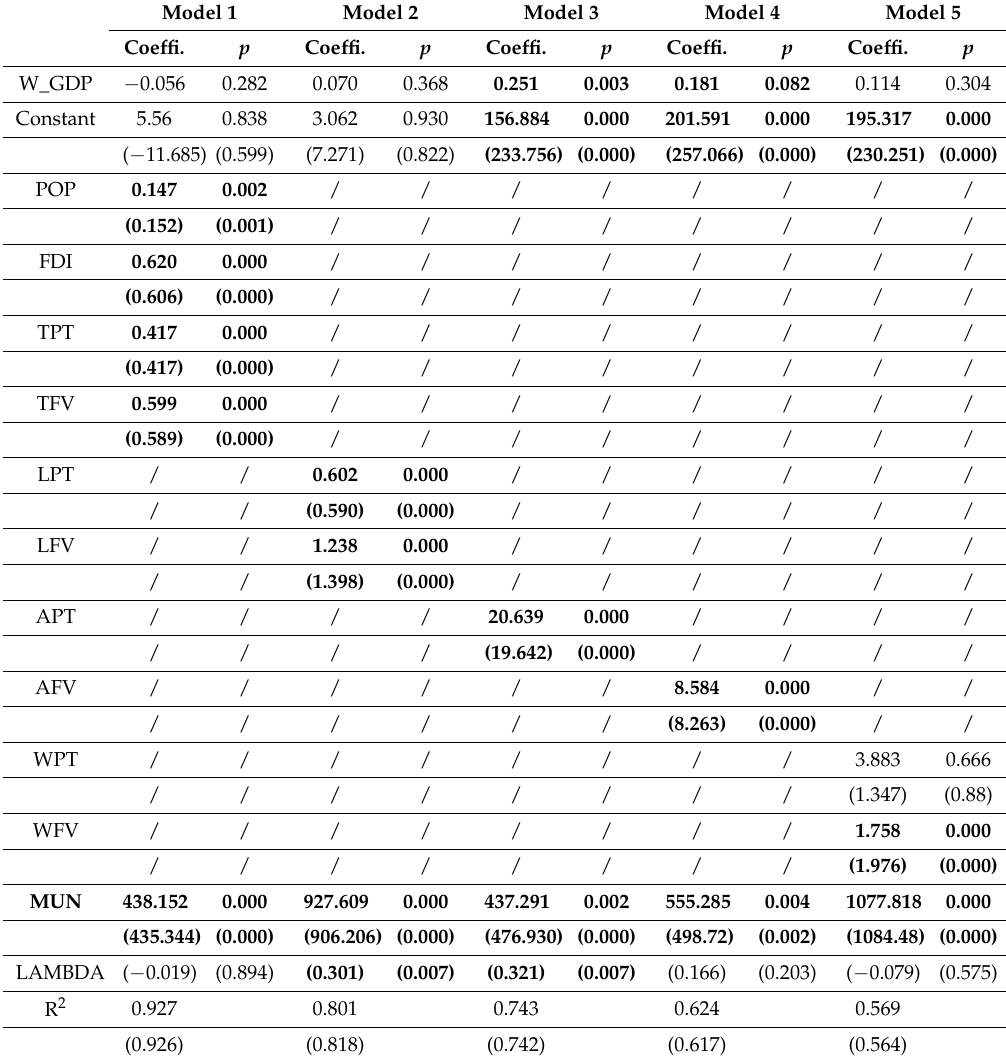
Table 6. SLM/SEM estimation results for the eastern